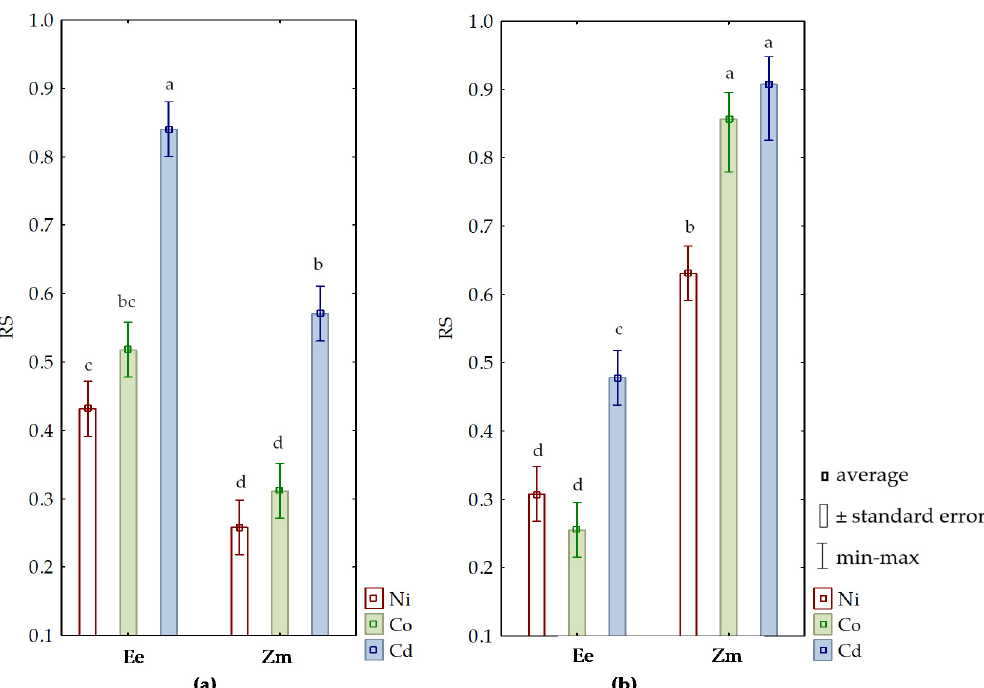
Figure 1. Resistance (RS) of Elymus elongatus L. and Zea mays L. to heavy metals. ( a )—above-ground parts; ( b )—roots; Ee— Elymus elongatus L.; Zm— Zea mays L.; Ni—soil contaminated with Ni 2+ ; Co—soil contaminated with Co 2+ ; Cd—soil contaminated with Cd 2+ . For each group of microorganisms, the same letters (a–d) are assigned to the same homogeneous groups. The same letters for above-ground parts and roots indicate no statistically significant differences.